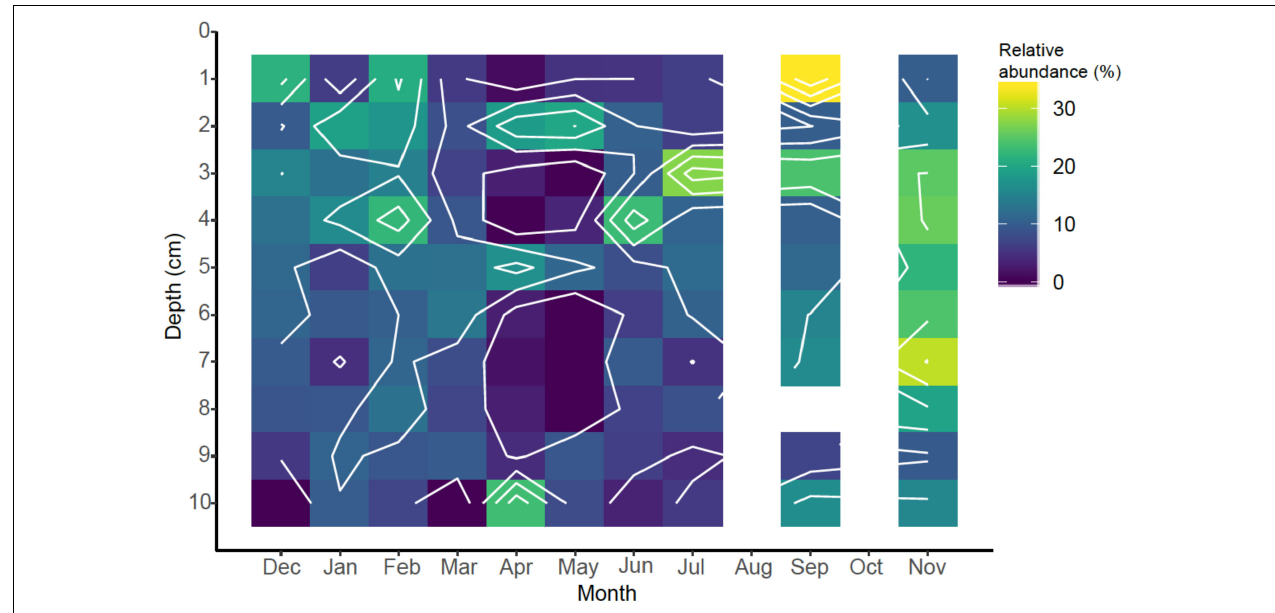
FIGURE 7 | Spatiotemporal relative abundance of diatoms (Bacillariophyta) in sediments identified by 18S rRNA gene sequencing.